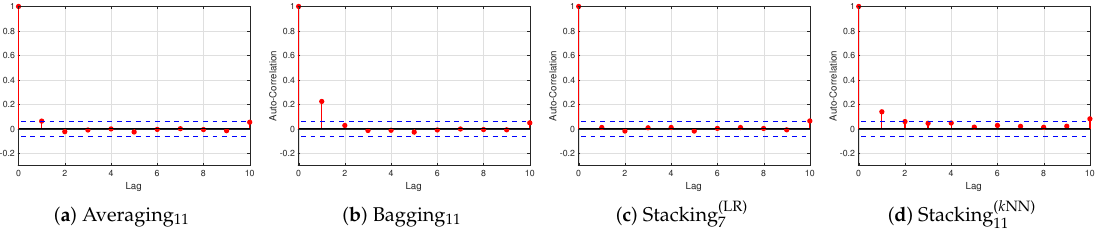
and stacking ( k NN) 7 11